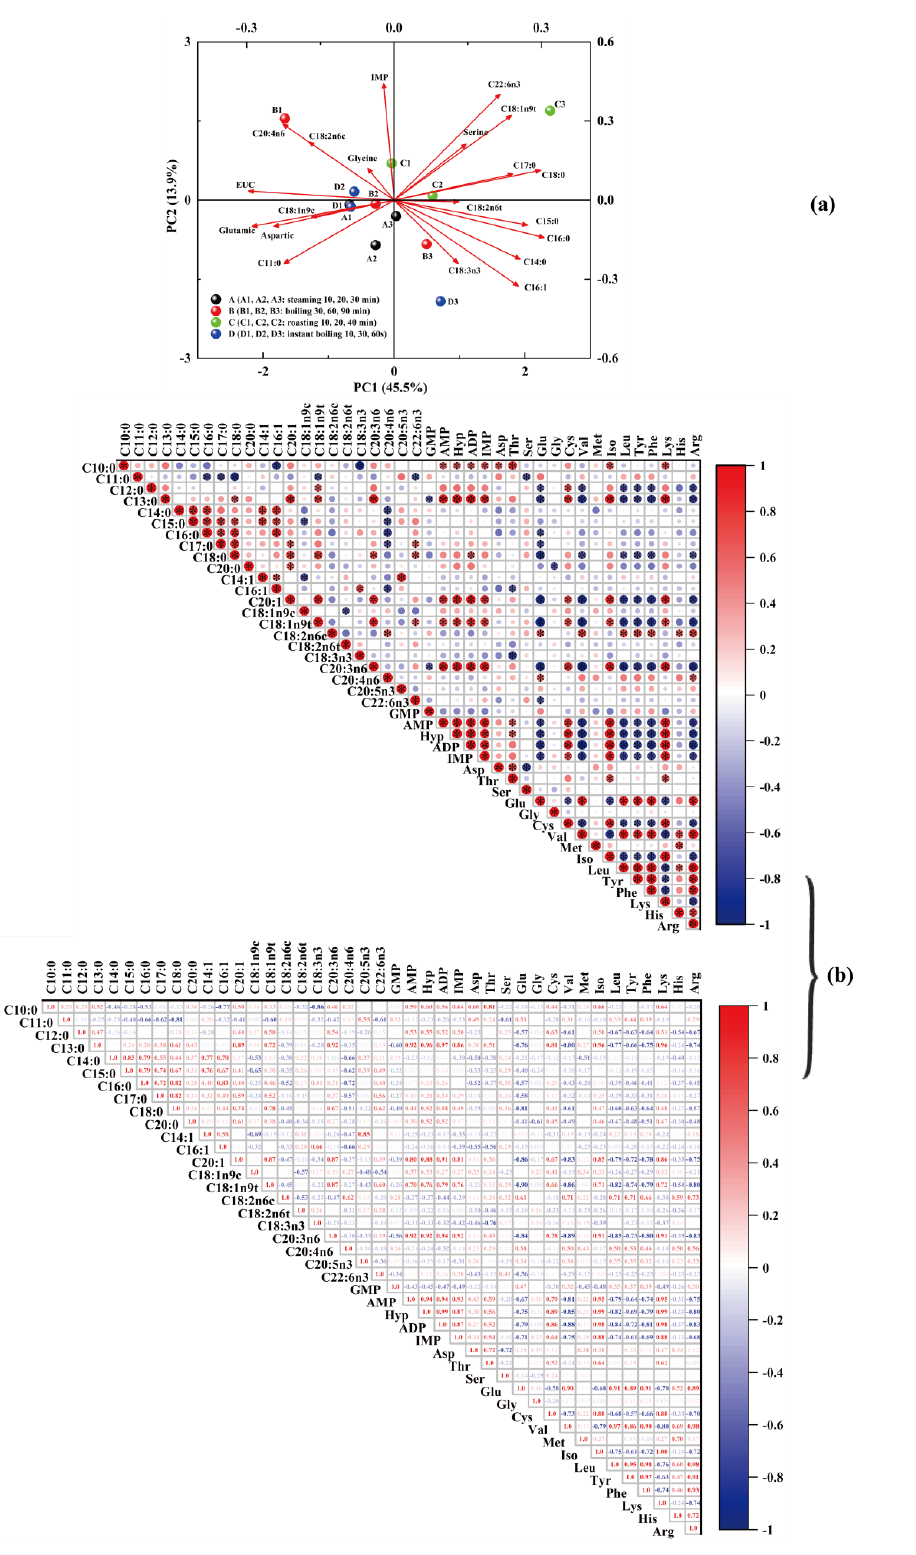
Figure 5. ( a ) Factor loading diagram of two principal components of non-volatile compounds in Pingliang red beef under different cooking methods. ( b ) The relationship between the non- volatile compounds (fatty acids, amino acids, and nucleotides) in Pingliang red beef under different cooking